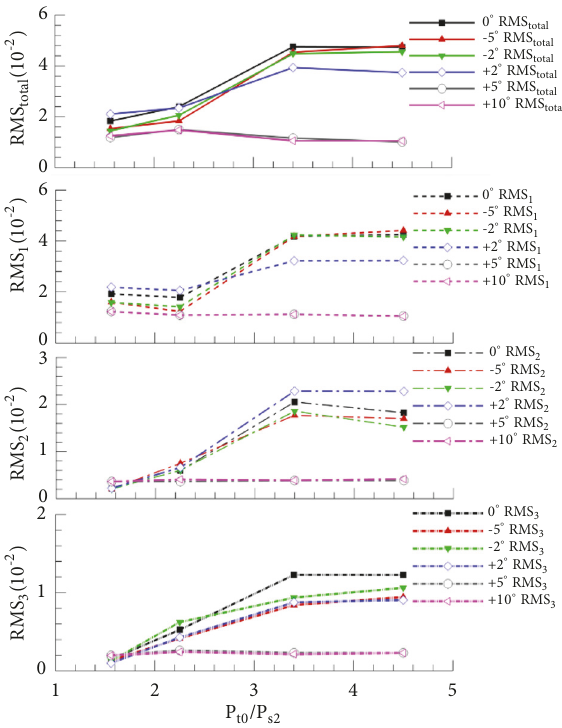
Figure 11: RMS pressure fluctuation at the midspan of VGT at various pressure